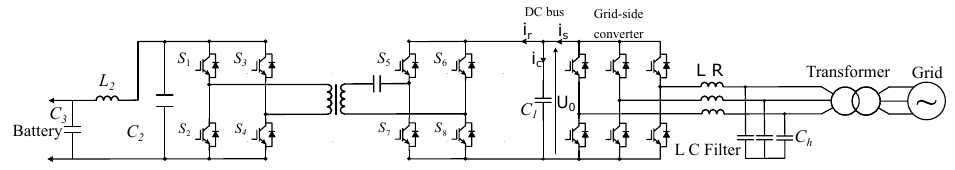
Figure 16. Contactless power transfer for EV charging.